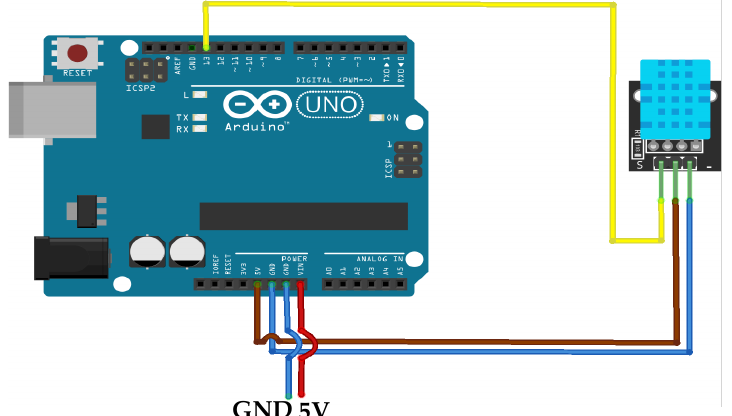
GND 5V Figure 9. The control circuit for displaying the temperature and humidity in the smart home.